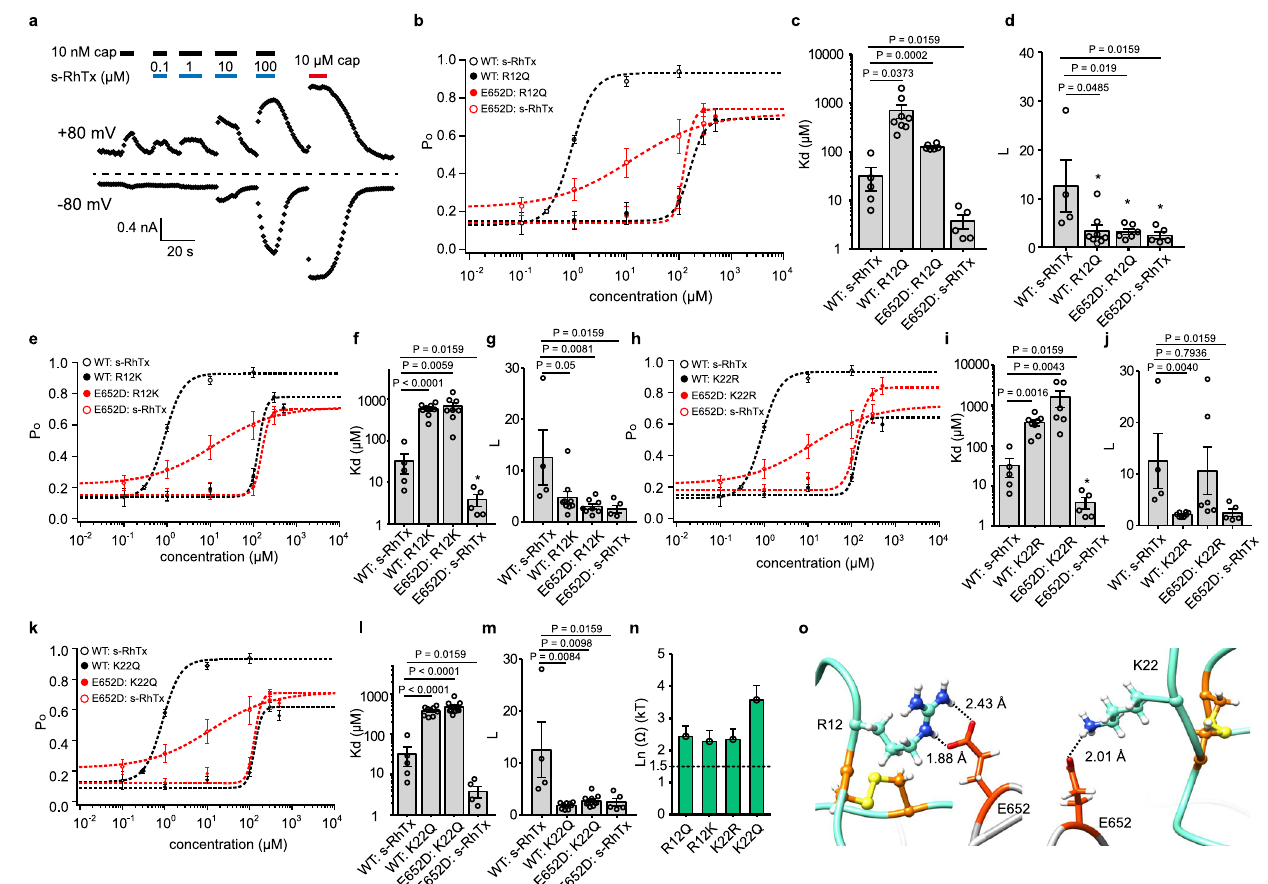
Fig. 5| Thermodynamics mutant cycleanalysisrevealedthe criticalrole of R12 and K22 in s-RhTx. a Concentration response of s-RhTx on E652D TRPV1 mutant. b Concentration – response curves of s-RhTx and R12Q on both WT and E652D TRPV1 channels (data were shown as mean±S.E.M. from biologically independent cells. WT:s-RhTx, n =5, WT:R12Q, n =8, E652D:s-RhTx, n =8, E652D:R12Q, n = 6). c and d ,Inthegeneralgatingofligands,ligandbindingisrepresentedbyKdandthe equilibrium constant between the closed and open states upon ligand binding is L . Kd and L values were calculated from concentration- response curves of b (Data were shown as mean ± S.E.M. from biologically independent cells. For Kd, n =5 for WT:s-RhTx, n =8forWT:R12Q, n =7forE652D:R12Q, n =5forE652D:s-RhTx.For L , n =4 for WT: s-RhTx, n = 8 for WT: R12Q, n = 7 for E652D:R12Q, n = 5 for E652D:s- RhTx. Two-sided t-test, the exact P values were labeled in the panels). e Concentration – response curves of s-RhTx and R12K on both WT and E652D TRPV1 channels (data were shown as mean±S.E.M. from biologically independent cells. WT:s-RhTx, n = 5, WT:R12K, n = 9, E652D:s-RhTx, n = 8, E652D:R12K, n = 8). f and g Kd and L values calculated from concentration – response curves of e (Data were shown as mean±S.E.M. from biologically independent cells; For Kd, n =5 for WT:s-RhTx, n =8forWT:R12Q, n =8forE652D:R12Q, n =5forE652D:s-RhTx.For L , n =4 for WT: s-RhTx, n = 9 for WT: R12Q, n = 8 for E652D:R12Q, n = 5 for E652D:s- RhTx. Two-sided t-test, the exact P values were labeled in the